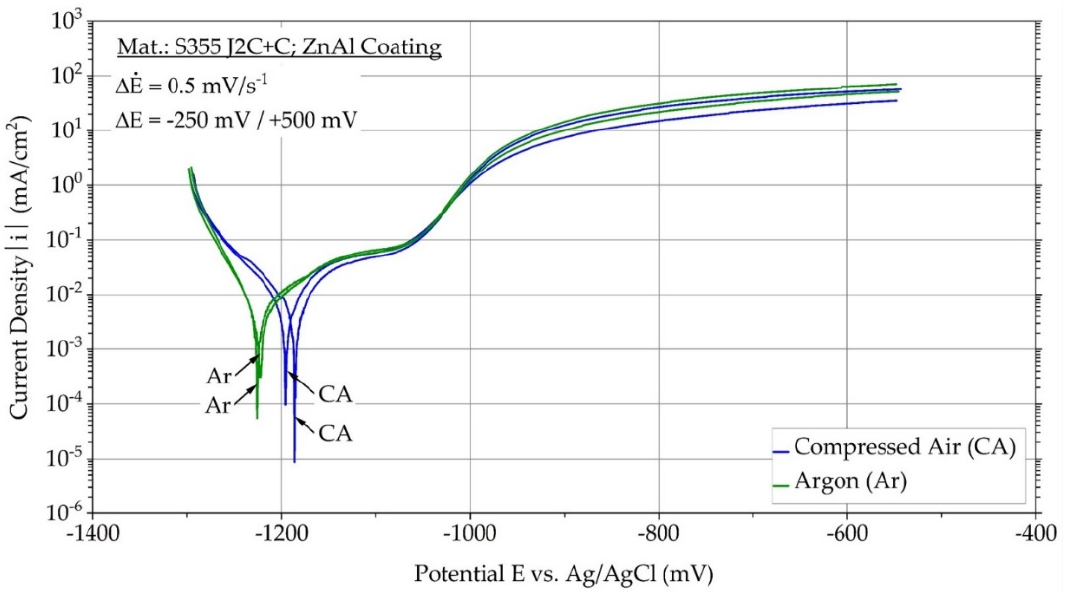
Figure 16. Potentiodynamic polarization curves of argon and compressed air sprayed coatings in as-sprayed conditions.